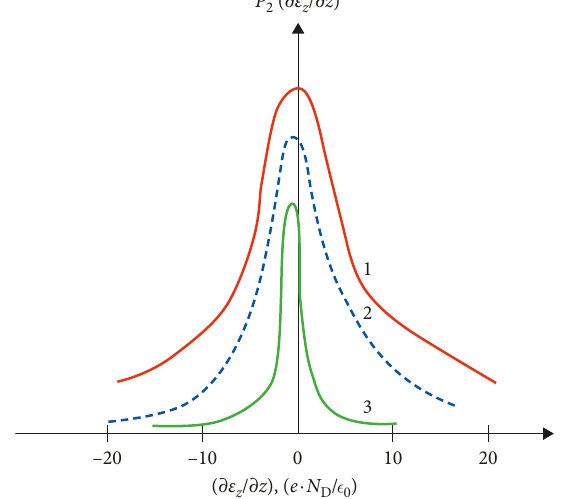
3 B (cid:29) ∗ 10 a . The B (cid:29) ∗